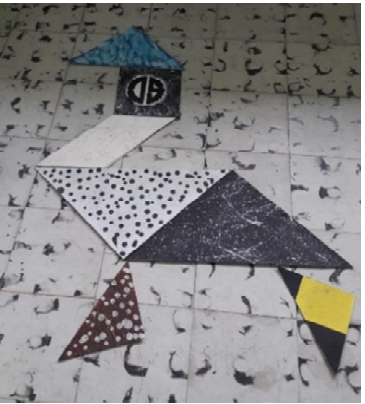
Figure 4. Geometric figures built from proportions as a way of doing art. With this activity, students were able to establish comparisons between figures through their measurements and proportions. In addition, the figures were used to make various two-dimensional